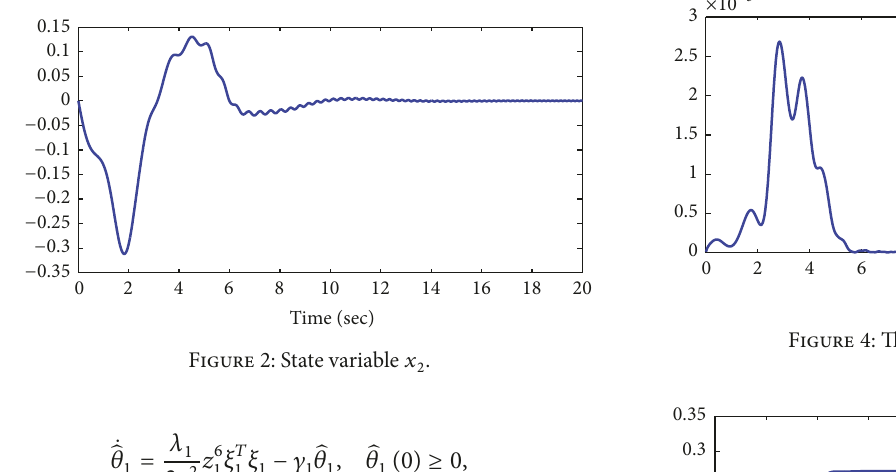
Figure 4: The adaptive parameter